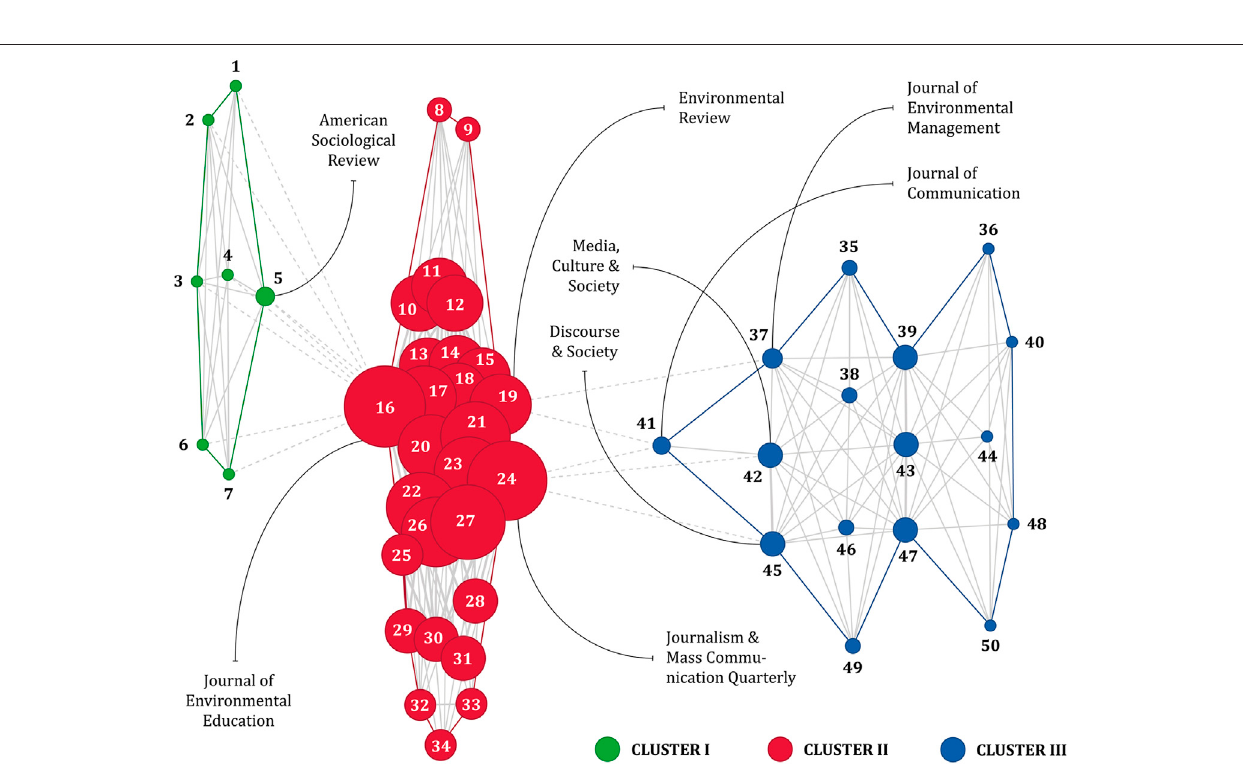
Frontiers in Environmental Science |